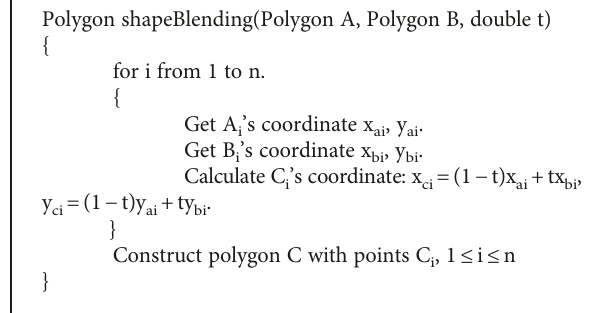
Algorithm 1: Polygon shapeBlending